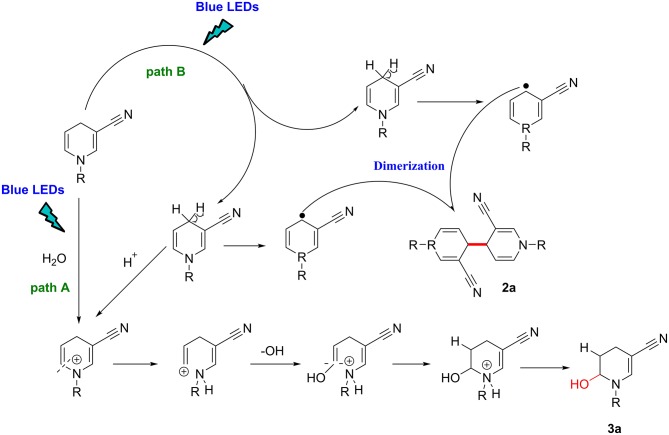
Proposed mechanism.